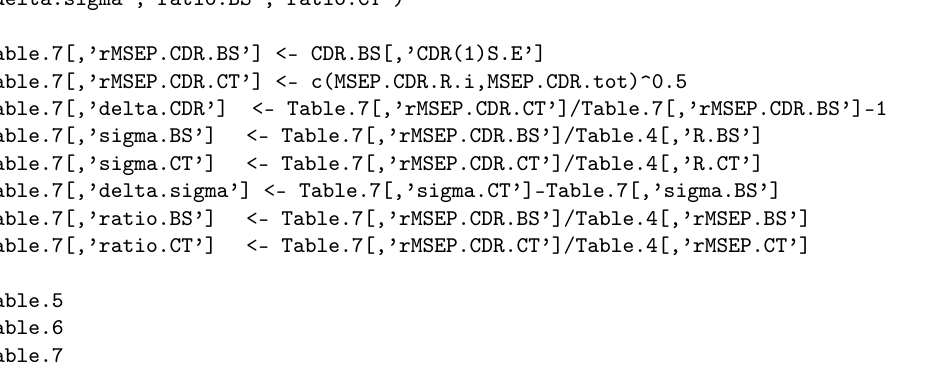
<- matrix(0, nrow= n.origin+1, ncol=8) colnames(Table.7) <- c(’rMSEP.CDR.BS’,’rMSEP.CDR.CT’,’delta.CDR’,’sigma.BS’,’sigma.CT’,